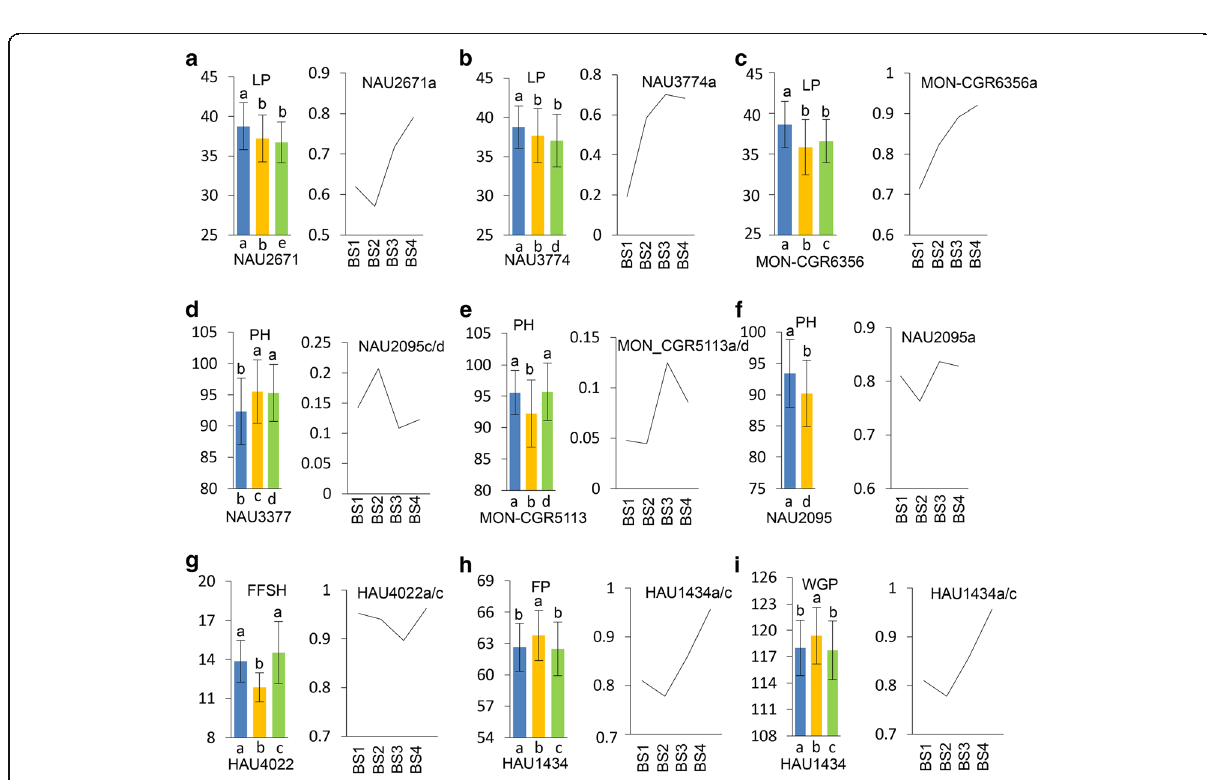
Fig. 6 The effects of different alleles of the major loci ( R 2 ≥ 3.0) and the favorable allele frequency trends in the four breeding stages. The phenotypic statistics of different alleles of NAU2671, NAU3774, MON-CGR6356, NAU3377, MON-CGR5113, NAU2095, HAU4022, and HAU1434 locus was shown in a-i (left chart). And the favorable allele frequency trends in the four breeding stages are shown in a-i (right